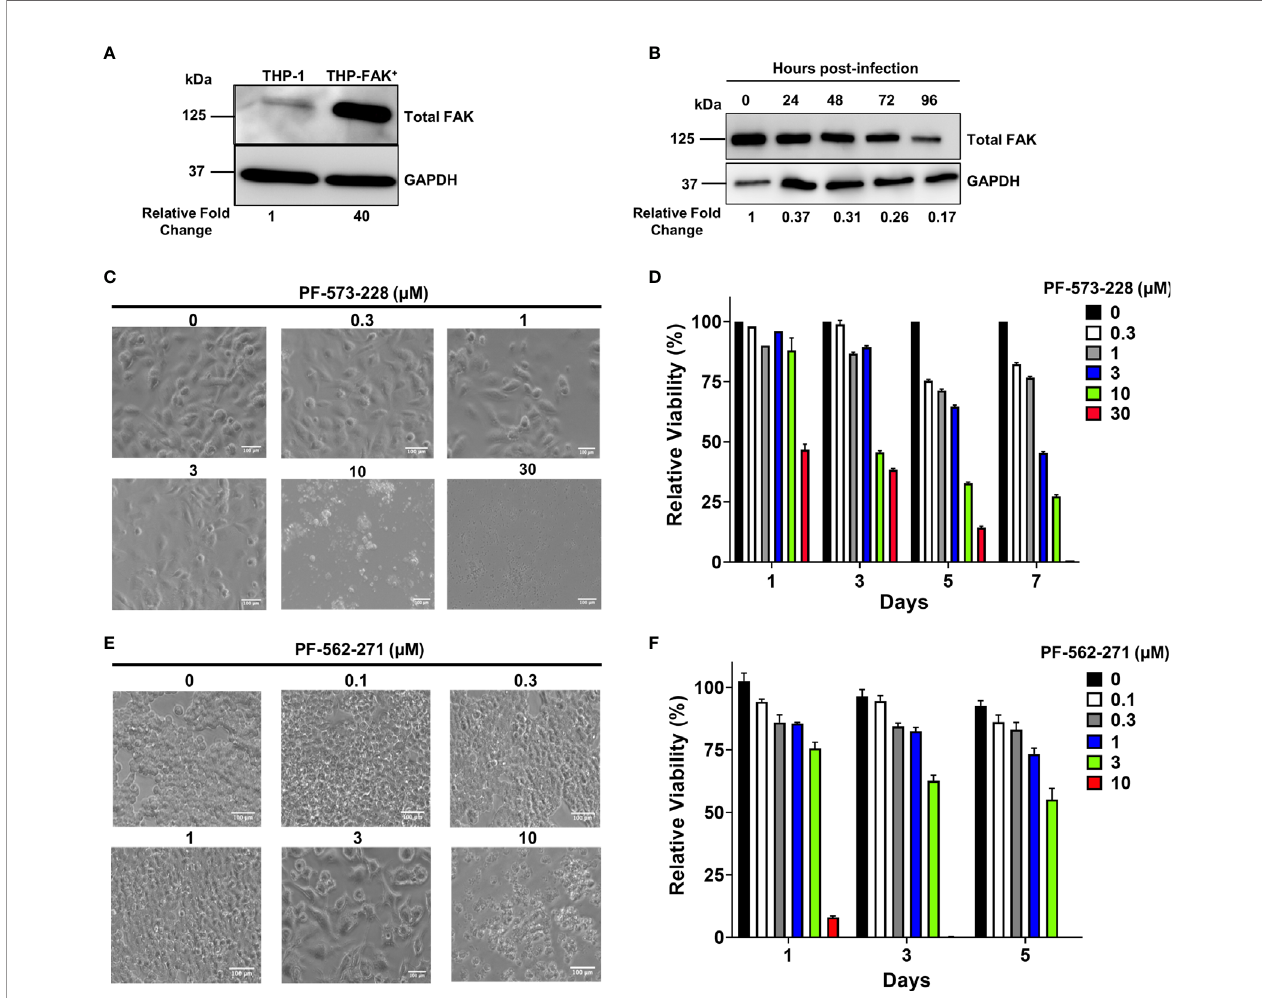
FIGURE 2 | Genetic overexpression and pharmacological inhibition of FAK. (A) Total FAK protein levels in cell lysates of THP-1 and THP-1 cells stably overexpressing FAK (THP-FAK + ) were analyzed by western blot. (B) THP-FAK + macrophages were infected with Mtb at an MOI of 10 and cell lysates were prepared at indicated time points, and analysed by western blot. Blots shown in (A, B) are representative of three independent experiments. Densitometry analysis of the blots were performed using Image Quant LAS 4000 software with intensities normalized to GAPDH. Relative fold change of total FAK levels was expressed relative to THP-1 cells (A) and uninfected THP-FAK + cells (B) . (C, D) THP-1 macrophages were treated with varying concentrations of PF-573-228 for 5 days, and (C) representative phase-contrast microscopy (20x objective) images are shown along with (D) quanti fi cation of cell viability using the resazurin assay. (E, F) RAW 264.7 macrophages were treated with varying concentrations of PF-562-271 for 5 days, and (E) representative phase-contrast microscopy (20x objective) images are shown along with (F) quanti fi cation of cell viability using the resazurin assay. Images are representative of 3 visual fi elds for each inhibitor concentration. Relative viability is normalized to untreated control cells as 100%. Error bars represent the mean ± SD of three independent biological replicates. Scale bar, 100 m